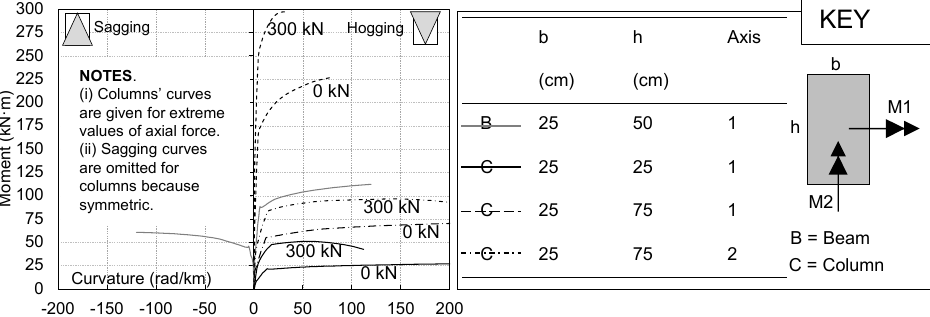
Figure 9. Moment–curvature diagrams for the cross sections of beams and columns of SPEAR frame. Results were obtained using the software Response 2000